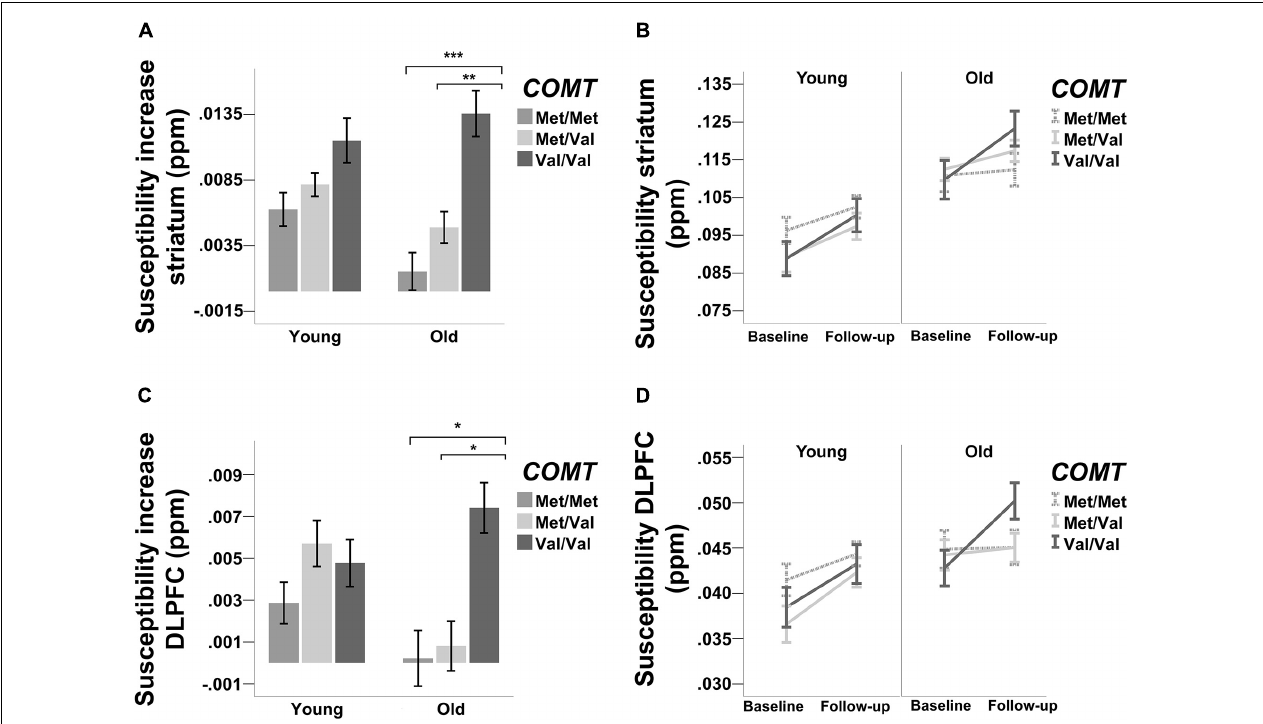
FIGURE 3 | Accumulation of iron [susceptibility increase in parts per million (ppm)] in (A,B) striatum and (C,D) DLPFC. Error bars ± 1 SE. * indicates significant difference in iron accumulation based on structural equation modeling (* p < 0.05, ** p < 0.01, *** p <